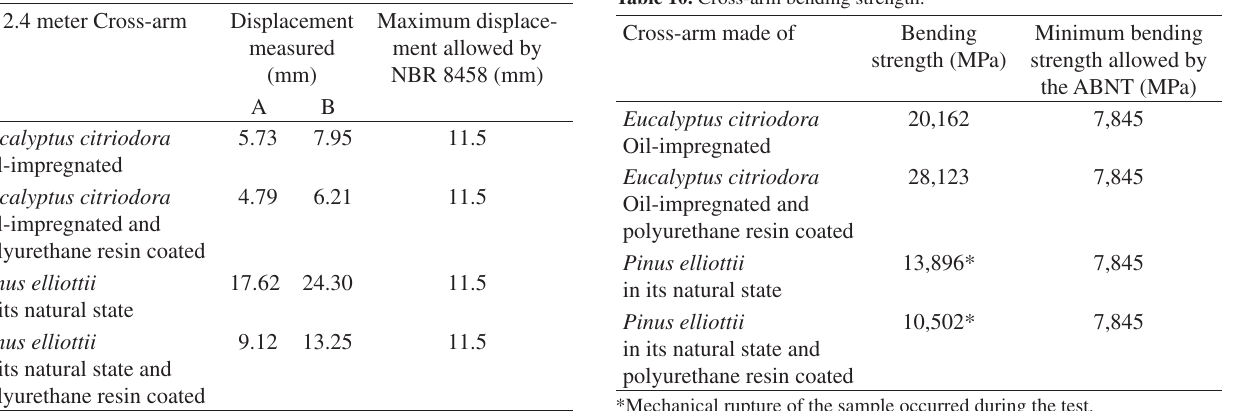
Table 8. Load bending test at 3.92 kN (400 kgf).